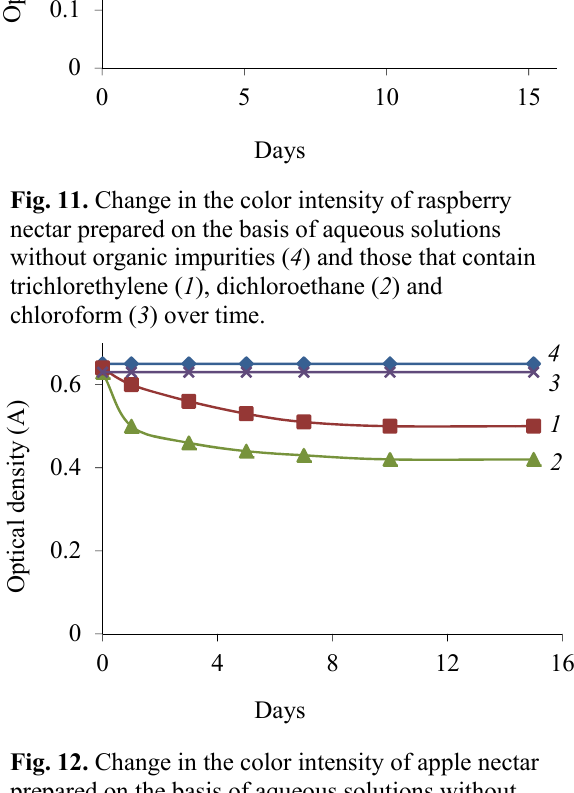
Fig. 12. Change in the color intensity of apple nectar prepared on the basis of aqueous solutions without organic impurities ( 4 ) and those that contain trichlorethylene ( 1 ), dichloroethane ( 2 ) and chloroform ( 3 ) over